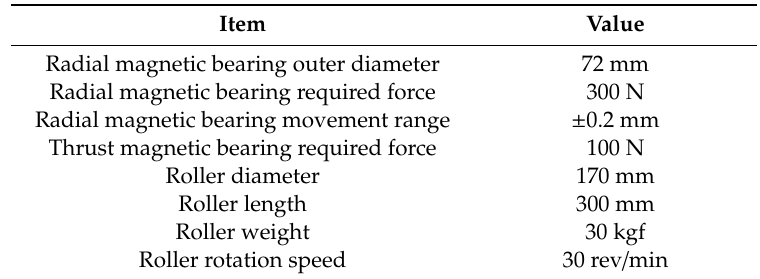
Figure 4. Configuration of precision roller with magnetic bearings for automatic alignment function. Table 1. Specifications of magnetic bearings.